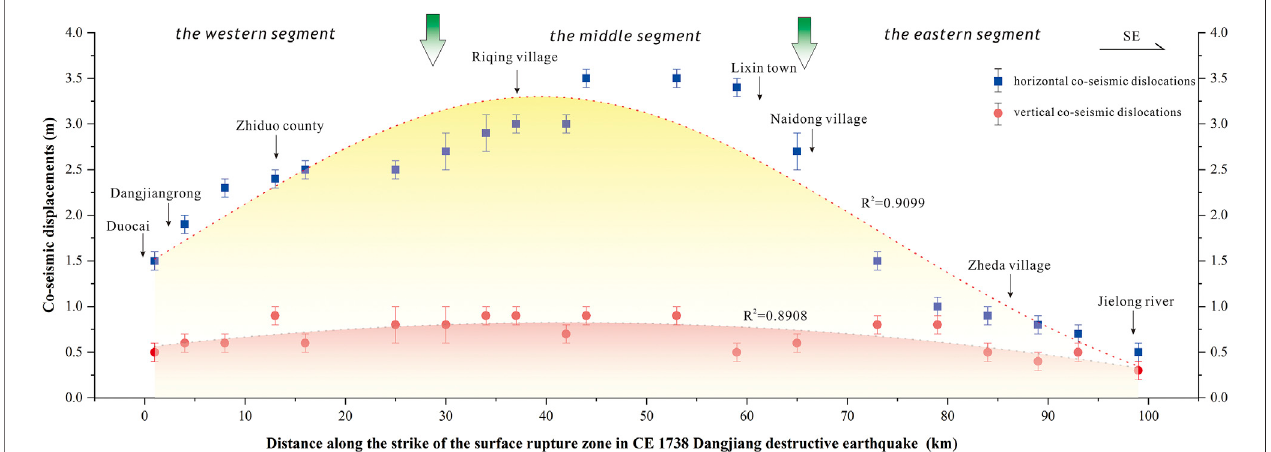
FIGURE 10 | Observed and fi tted mean co-seismic displacements in the CE 1738 Dangjiang historical earthquake identi fi ed from linear geomorphic markers on high-resolution satellite images and fi eld measurements. The arrows with green gradients represent the approximate position of the segment along the strike of the co- seismic surface rupture zone. Blue and red marks represent horizontal and vertical co-seismic dislocations, respectively, along the strike of the surface rupture zone resulting from the CE 1738 Dangjiang M 7.6 surface faulting event (see the text for detailed discussions). The fi tted fi gure shows that the maximum co-seismic displacements are mainly concentrated in the central part of the fault sections and sharply decrease toward the fault